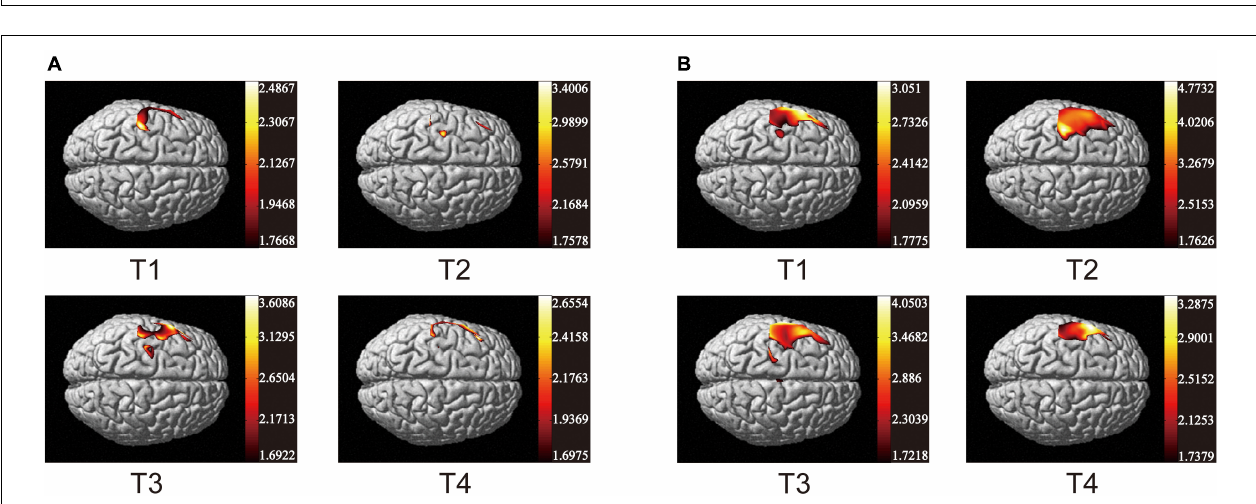
FIGURE 2 | Basic experimental setup. (A) Cerebral cortical channel placement; (B) a map of the regions of the brain covered by light poles. Blue: supplementary motor area (SMA) and pre-motor area (PMA); green: the primary somatosensory cortex (S1); and red: primary motor cortex (M1). (C) Experimental environment and process diagram; (D) schematic diagram of 27 channels. Yellow circles: 10 transmitters; blue circles: 8 receivers; and white circles: 27 channels.